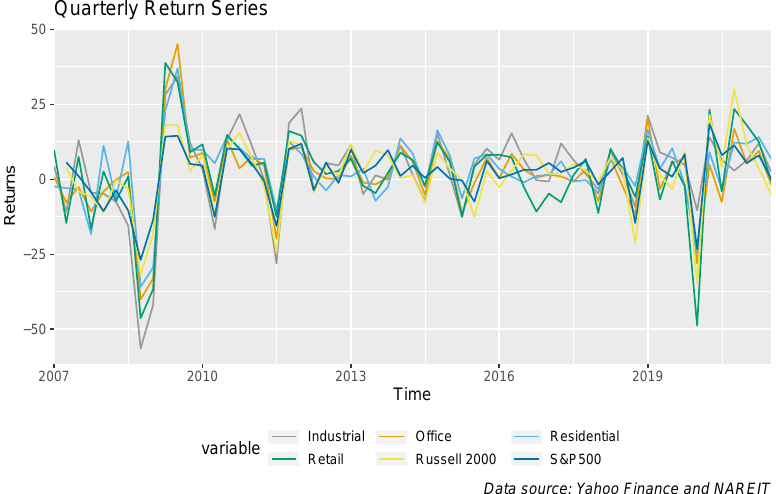
Figure 1. Total Return Series of REITs and Market Portfolio